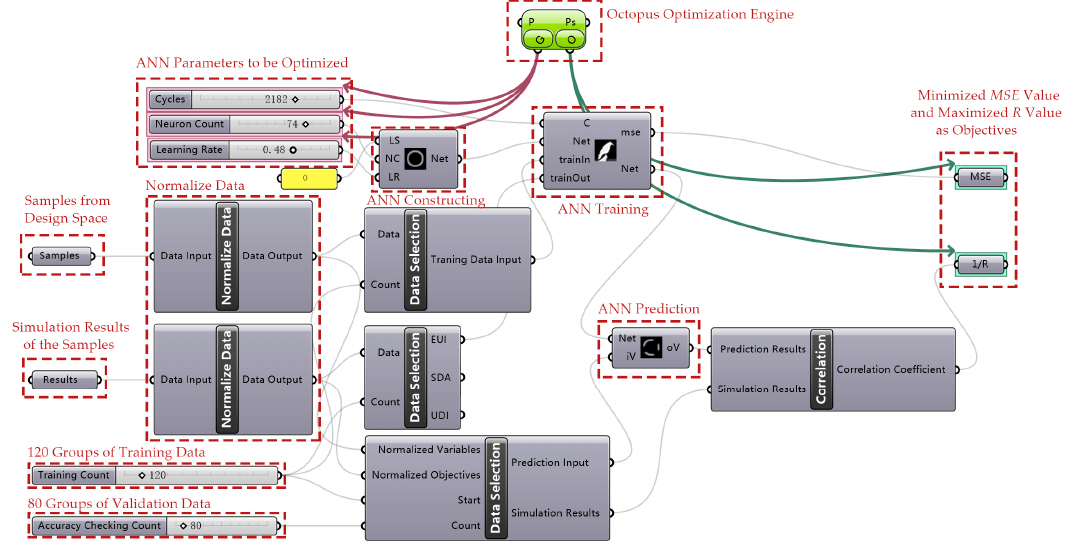
Figure 9. ANN Modeling and Training Module.